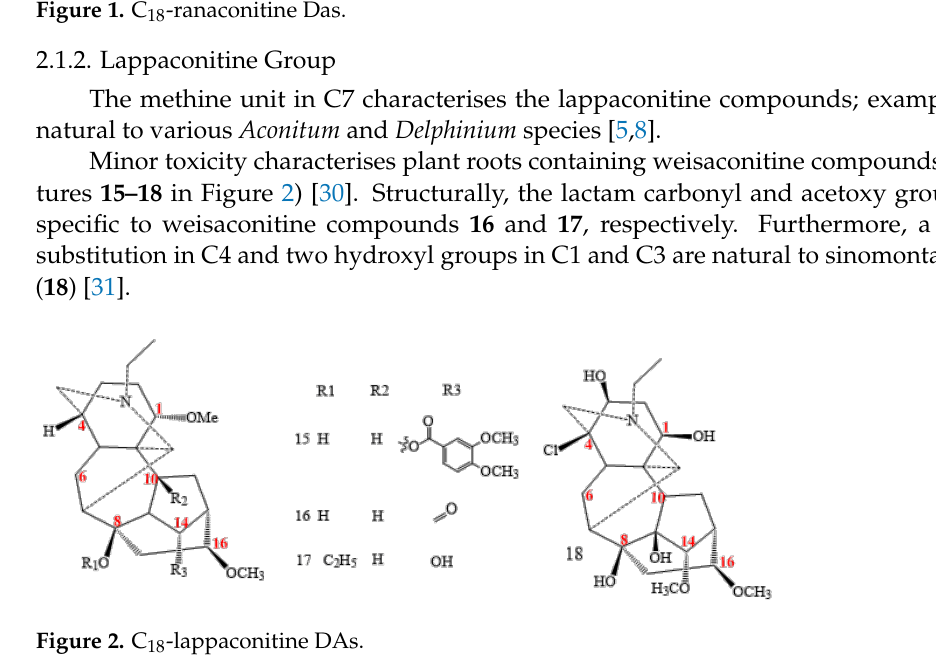
Figure 1. C 18 -ranaconitine Das.